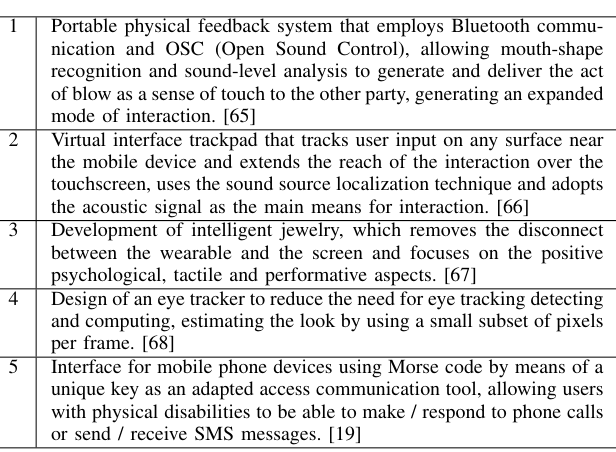
TABLE IX E XAMPLES OF MOBILE COMPUTING